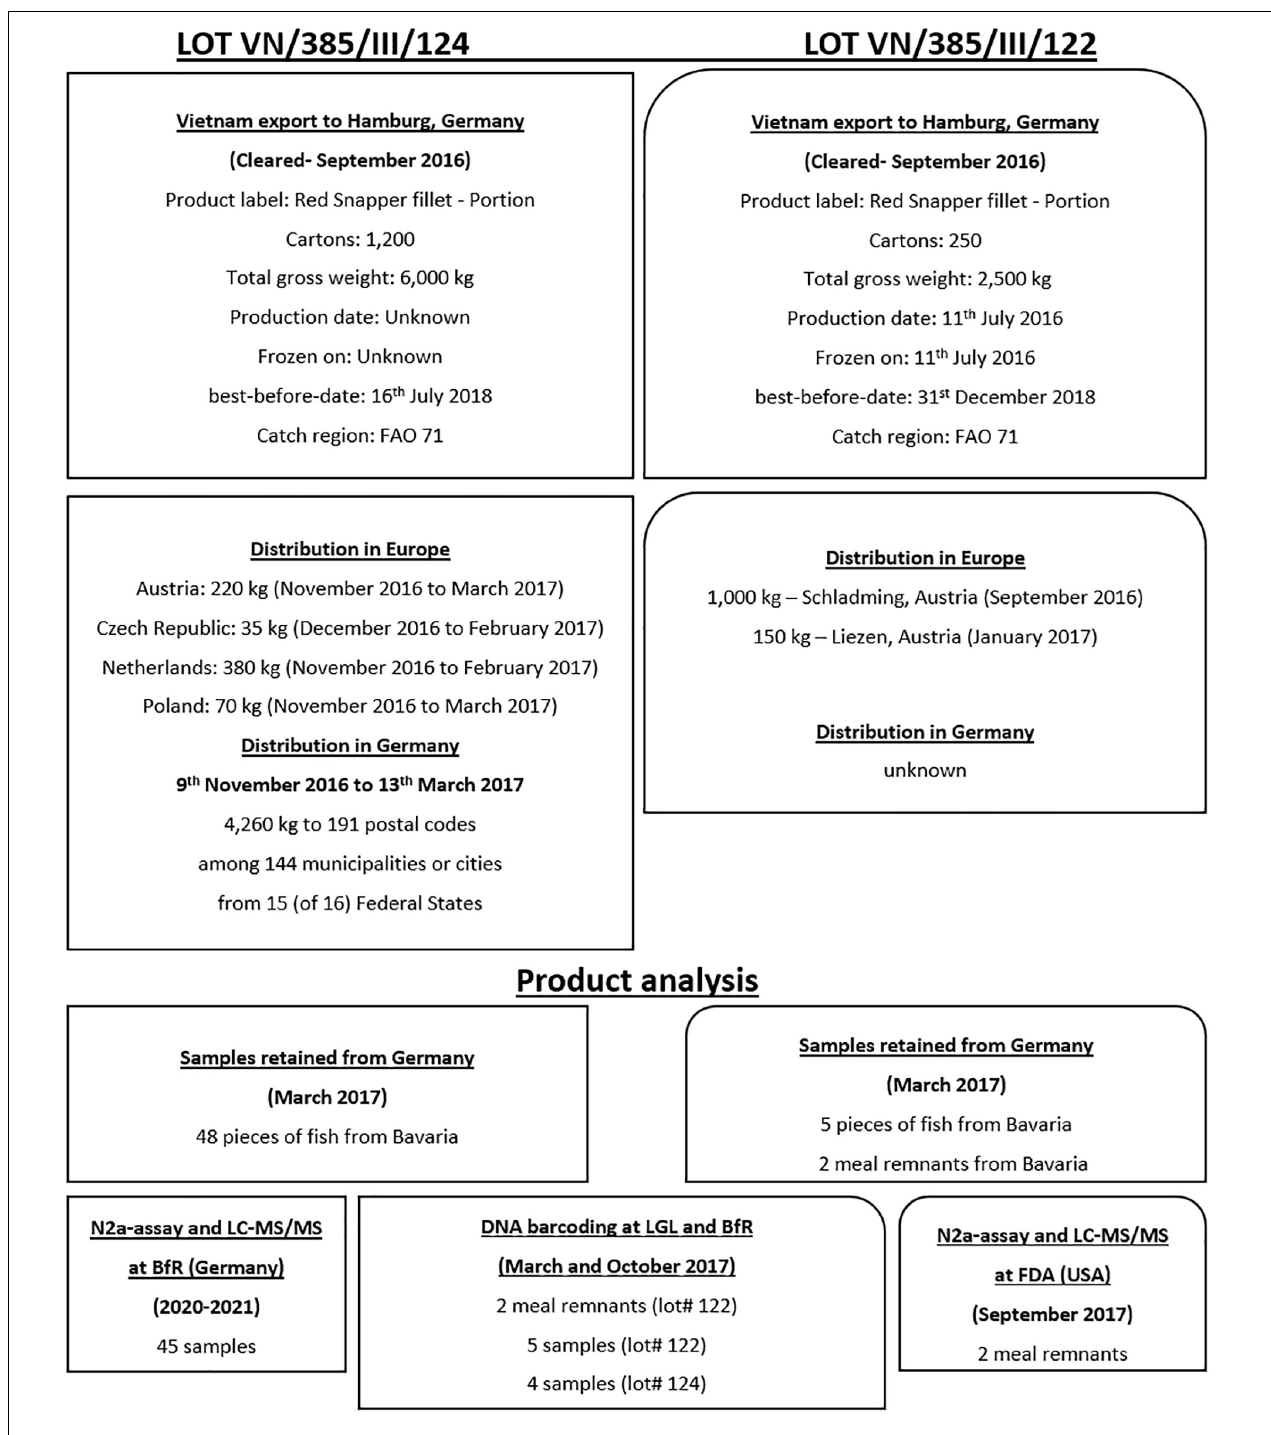
FIGURE 1 | Description of both lots involved in the CP outbreaks in Germany. Import descriptions, distribution, and product analysis information for both lots are shown.